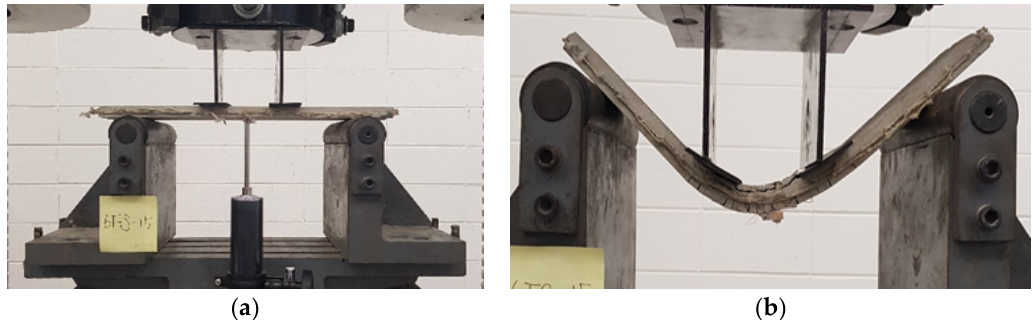
Figure 2. Flexural test with 3D-TRM panel: ( a ) Test setup; ( b ) End of test.